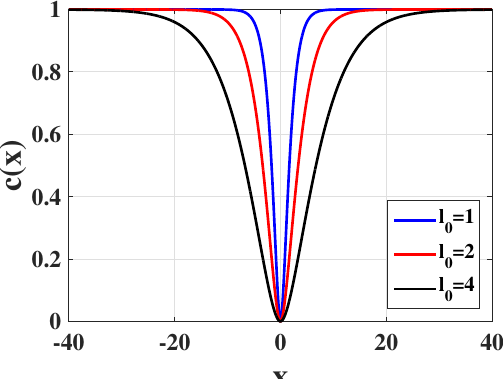
Figure 9. Fourth-order quadratic approximation: Effect of the length-scale parameter l 0 on the width of